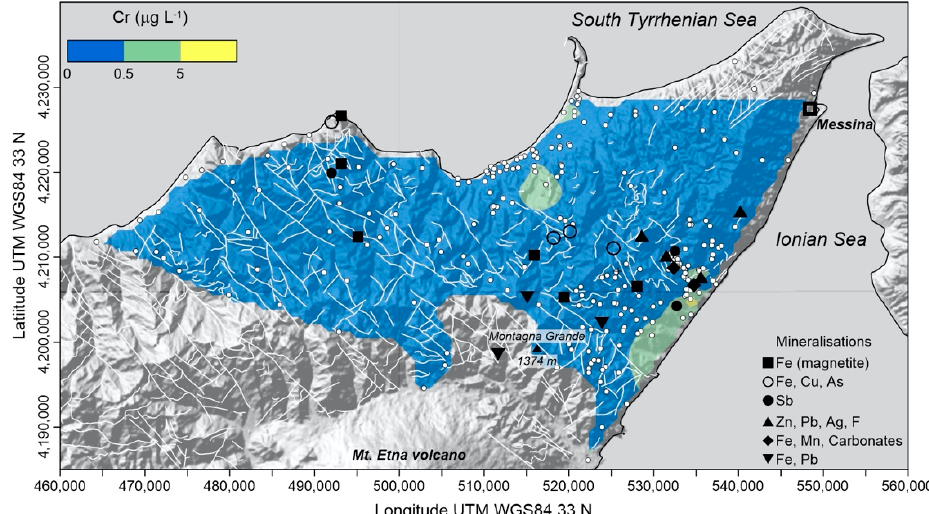
Figure 8. Concentration distribution map of Cr, reporting locations of sampling points (with indication of those exceeding the related MACs) and main mineral deposits; tectonic lineaments (white lines) are also illustrated.